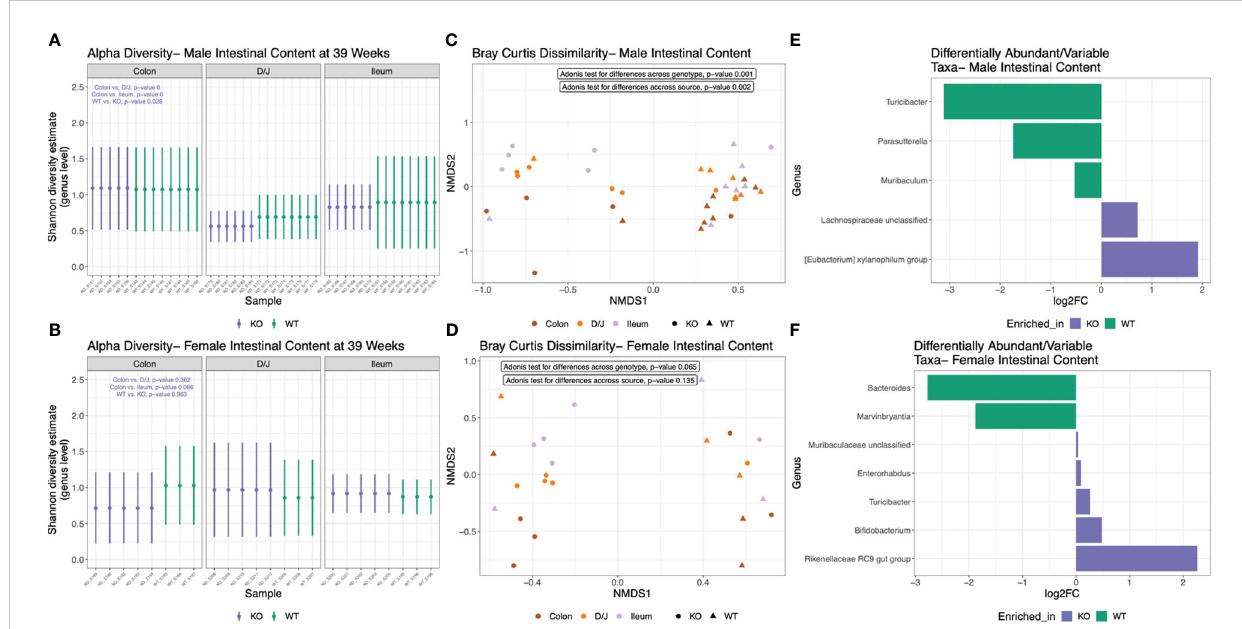
FIGURE 6 Nlrp12 de fi ciency induces dynamic changes in intestinal microbiota diversity and composition. Intestinal microbiota was collected at the endpoint of 39 weeks of age. (A, B) Alpha diversity of intestinal microbiota based on Shannon diversity estimate in male (A) and female (B) B6/ lpr mice upon alteration of NLRP12. (C, D) Non-metric multidimensional scaling showing the segregation of intestinal microbiota based on Bray Curtis dissimilarity of beta diversity in male (C) and female (D) mice. (E, F) Differentially abundant bacterial taxa at the genus level in male (E) and female (F) intestinal